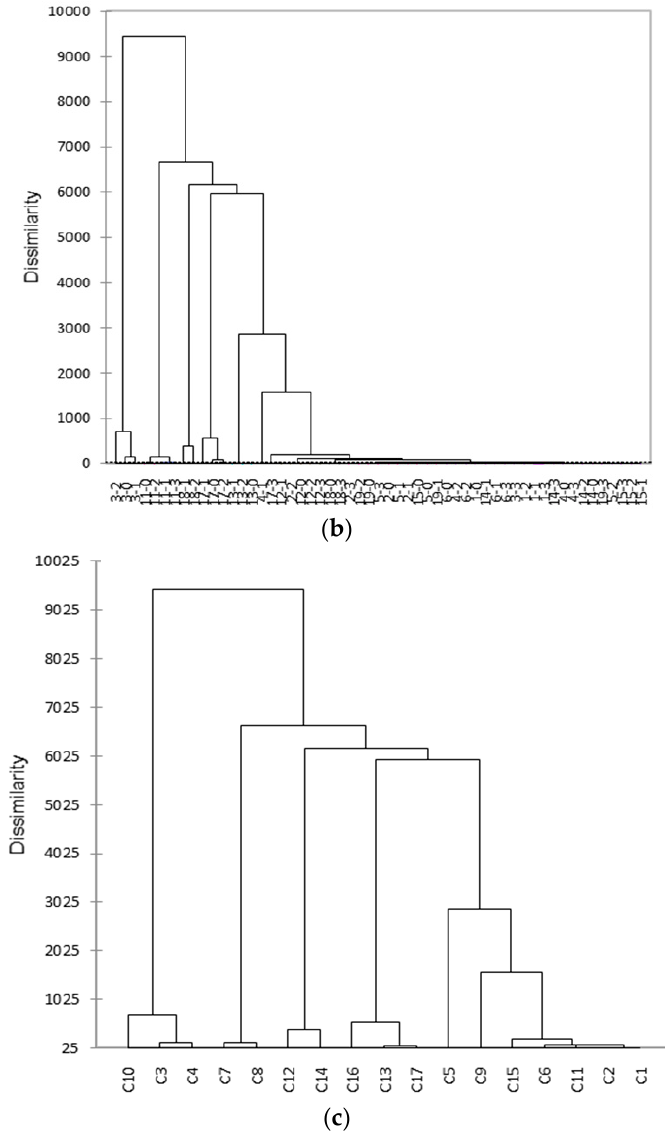
Figure 3. Longitudinal principal component analysis (PCA) and agglomerative hierarchical clustering (AHC) to monitor IGH repertoires in all 14 renal transplant patients. ( a ) The PCA charts represent the observations in the PCA space. A new set of variables or principal components (PCs) were created to describe more complex variability in the datasets. The first PC (PC1) explains the maximum variance of the datasets, followed by PC2, and so on. X and Y axes show principal components 1 (F1) and 2 (F2), and the percent variation explained by each component is shown in parenthesis. Time sequence of blood sample drawn is marked as separate sample numbers in an ascending order. ( b ) Longitudinal AHC for IGH repertoires in the patients (sample view) and ( c ) cluster view, C in X axis represents individual cluster of gene expression. All the numbers in the figures represent sample numbers rather than patient numbers due to original designations. (The numbers 1, 2, 3, 4, 5, 6, 11, 12, 13, 14, 15, 17, 18, and 19 represent the samples from patient numbers 1, 2, 3, 4, 5, 6, 7, 8, 9, 10, 11, 12, 13, and 14, whereas the 0, 1, 2, and 3 following the hyphen represent the times T0, T1, T2, and T3 when the blood was sampled).